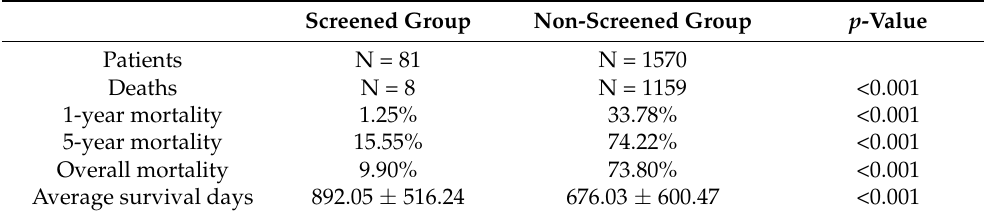
Table 2. Clinical outcomes and mortality profiles of non-smokers with lung cancer according to screening status.